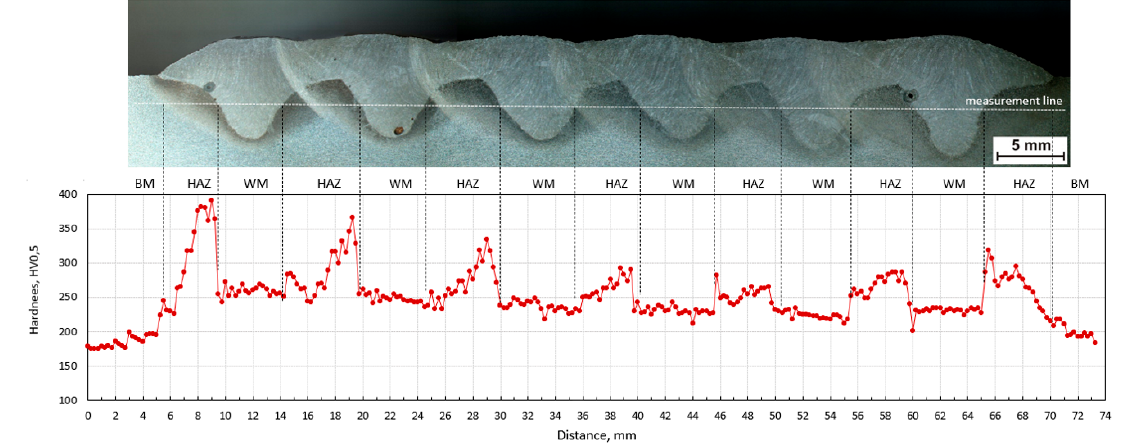
Figure 17. Hardness HV 0.5 distribution in plate A; BM—base material, W—weld metal, HAZ—heat-affected zone.